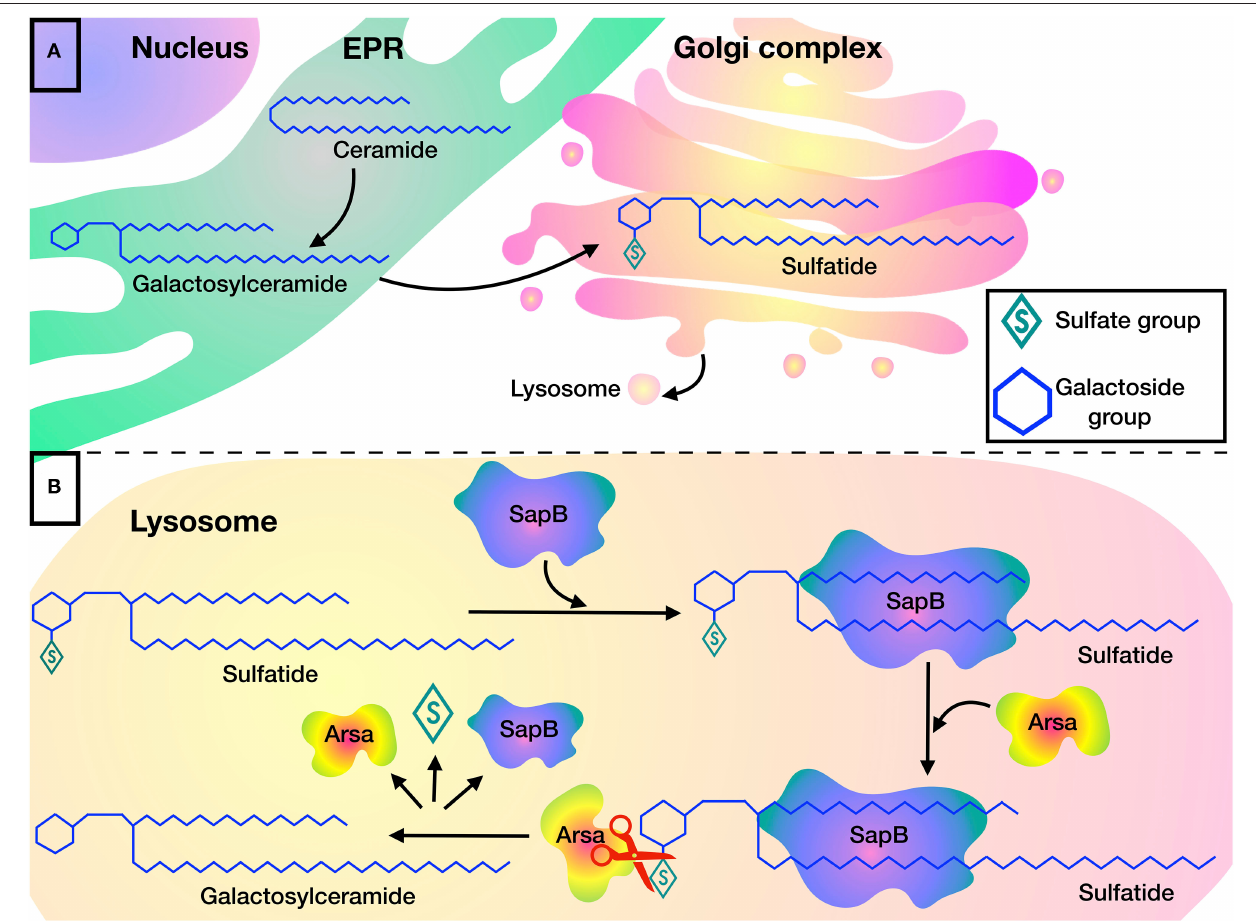
FIGURE 1 | Sulfatide metabolism: (A) Biosynthesis of sulfatides begins in the EPR, where galactosylceramide is formed by transferring galactose to ceramide, after which galactosylceramide is transported to the Golgi complex where sulfatides are formed by addition of a sulfate group. (B) Degradation of sulfatides occurs in the lysosome. SapB is required for the presentation of sulfatide to the active site of ARSA. ARSA hydrolyzes sulfatide to galactosylceramide by cleaving the sulfate group.